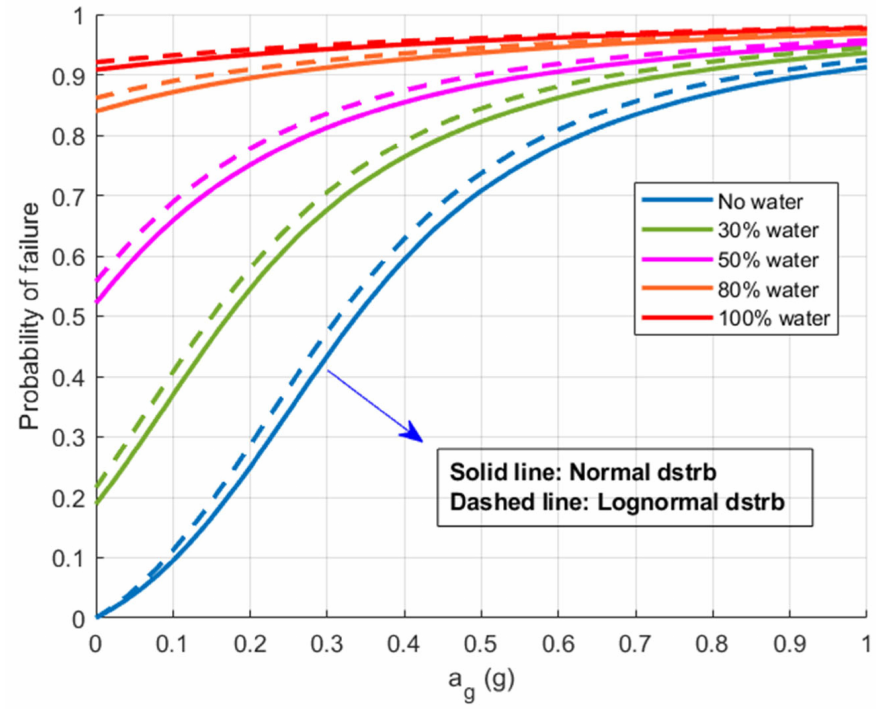
Figure 10. Fragility curves of rock slope planar sliding for the island of Thasos, in terms of peak ground acceleration (a g ) and percentage of fill of the discontinuities with